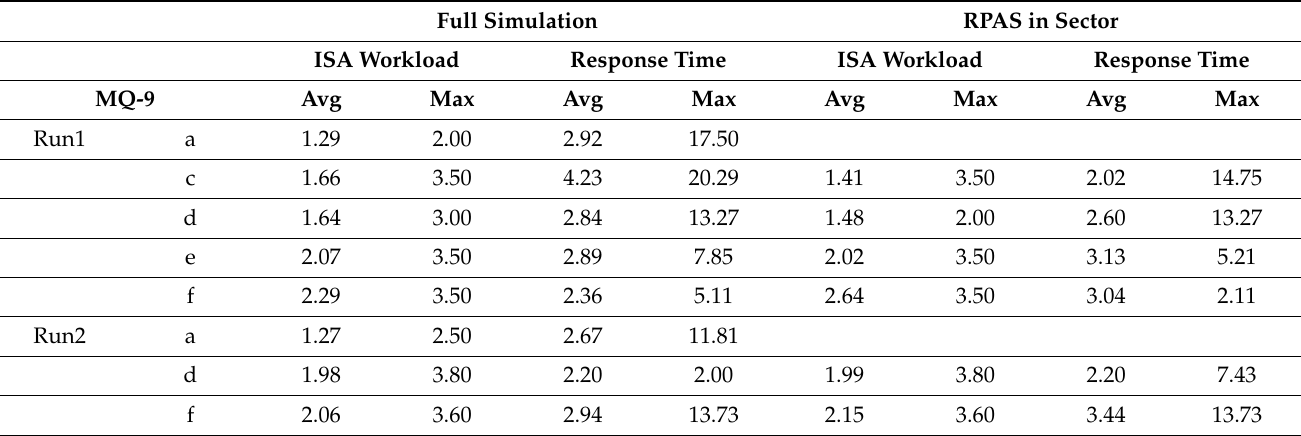
Table 10. ISA data recording for the MQ-9 contingency simulations.